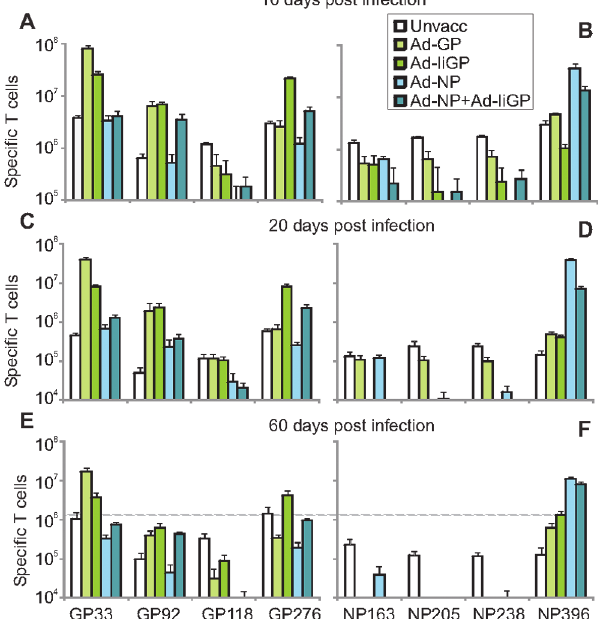
Spleens were harvested at 10 ( a-b ), 20 ( c-d ) and 60 ( e-f ) days post infection, and numbers of IFN- γ producing epitope specific CD8+ T cells were determined for GP ( a, c, e ) and NP epitopes ( b, d, f ). Mean +SEM of 7 – 8 mice per group pooled from two separate experiments. The dotted line in e-f shows the magnitude of the NP396 specific response achieved in Ad-IiGP vaccinated mice.